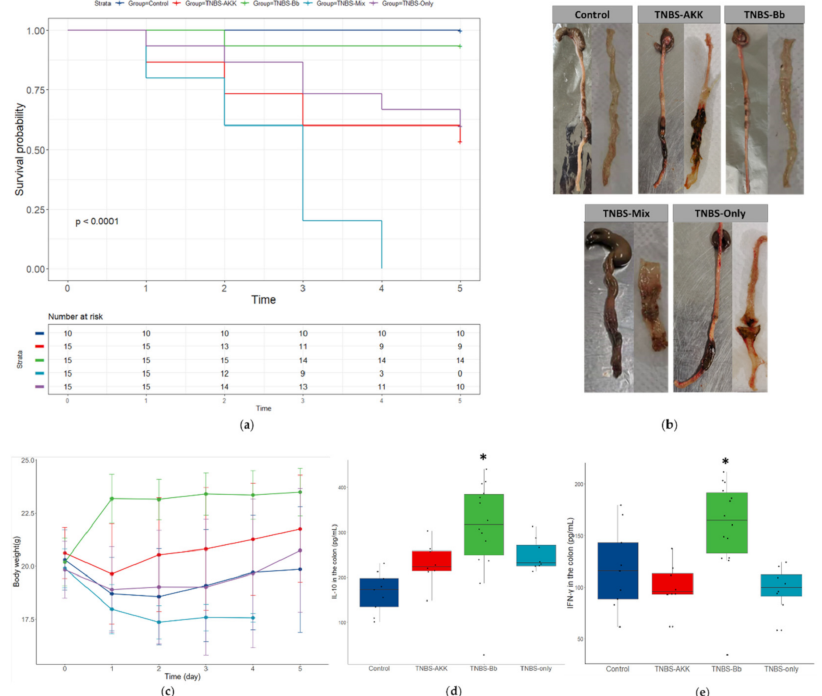
Figure 4. The administration of a mixture of A. muciniphila and C. butyricum significantly increased the mortality of TNBS-challenged mice. ( a ) Survival curve. ( b ) Changes to gross intestines on the fifth day after the TNBS challenge. ( c ) Changes in mouse body weight. ( d , e ) Levels of cytokines (IL-10, IFN- γ ) in colon tissue on the fifth day after the TNBS treatment. No statistically significant differences were observed among groups in ( b – e ) when tested by Tukey’s HSD. Data about cytokine levels in the TNBS-Mix group were missing for their 100% death rate on the fifth day. * p <